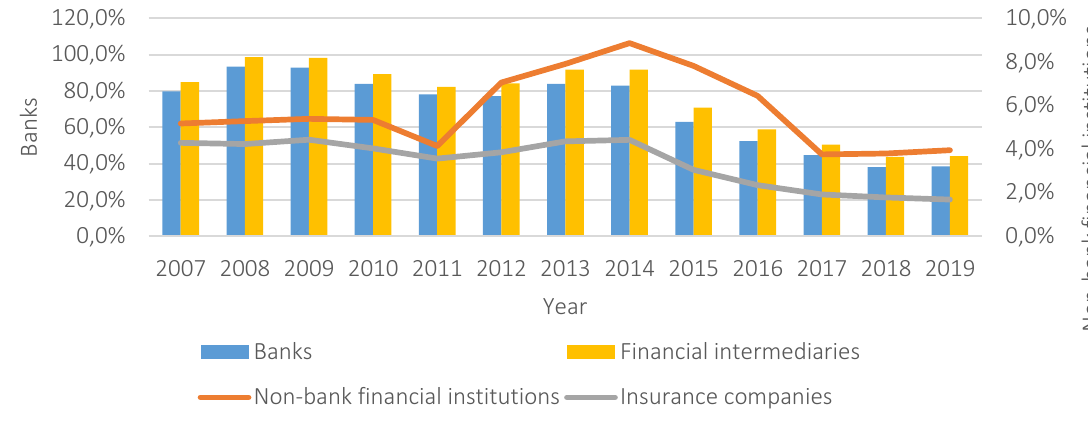
Figure 1. Share of financial intermediaries’ assets in Ukraine’s